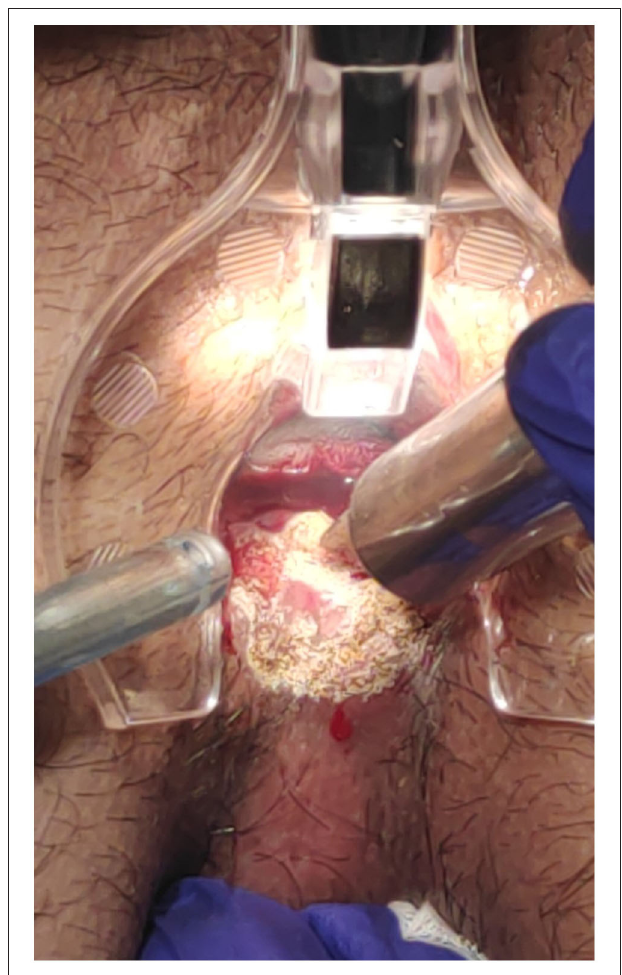
FIGURE 5 | Posterior fissure: ongoing CO 2 laser